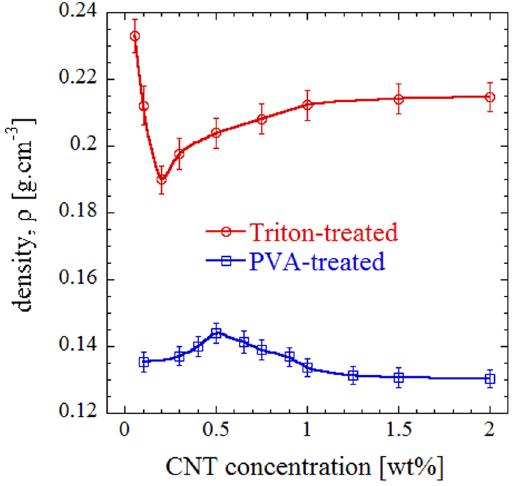
Figure 4. Density variation of porous samples as a function of CNT concentration for the two functionalization